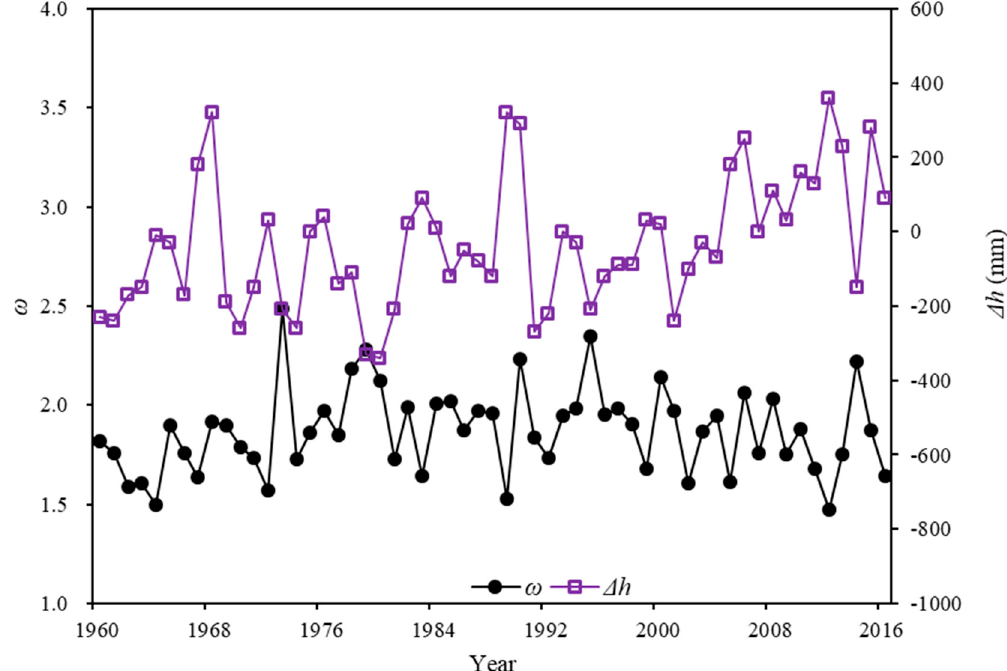
Figure 6. Variation the empirical parameter representing catchment characteristics ( ω ) and Δ h in Qinghai Lake basin during the period of 1960–2016.